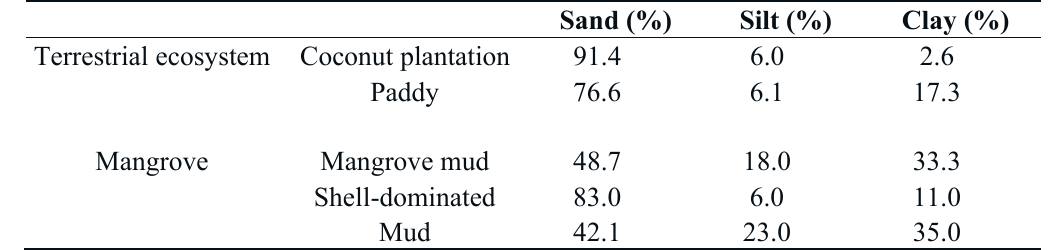
Table 2. Particle size distribution of soils/sediments collected from terrestrial and mangrove ecosystems. In the mangrove ecosystem, sublayers were also examined.